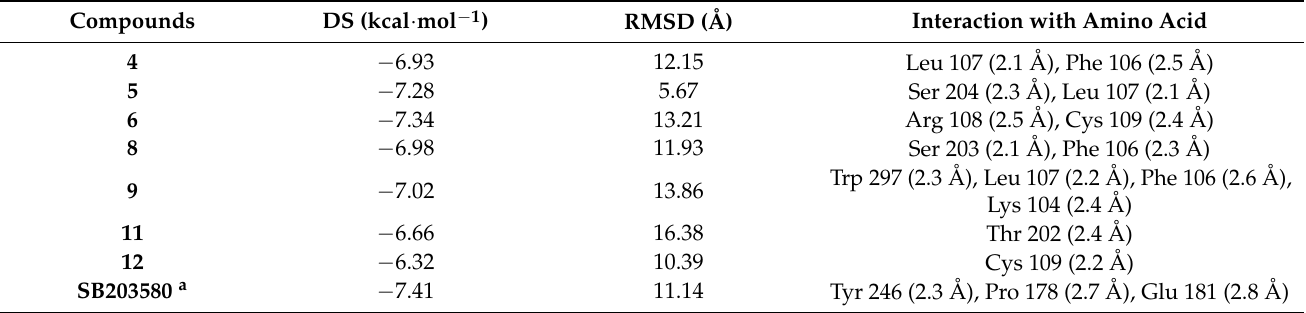
Table 3. Docking simulation results with docking score energy (DS) and root-mean-square deviation (RMSD) between isolated compounds ( 4 – 6 , 8 , 9 , 11 , and 12 ) and the 1F42 protein.